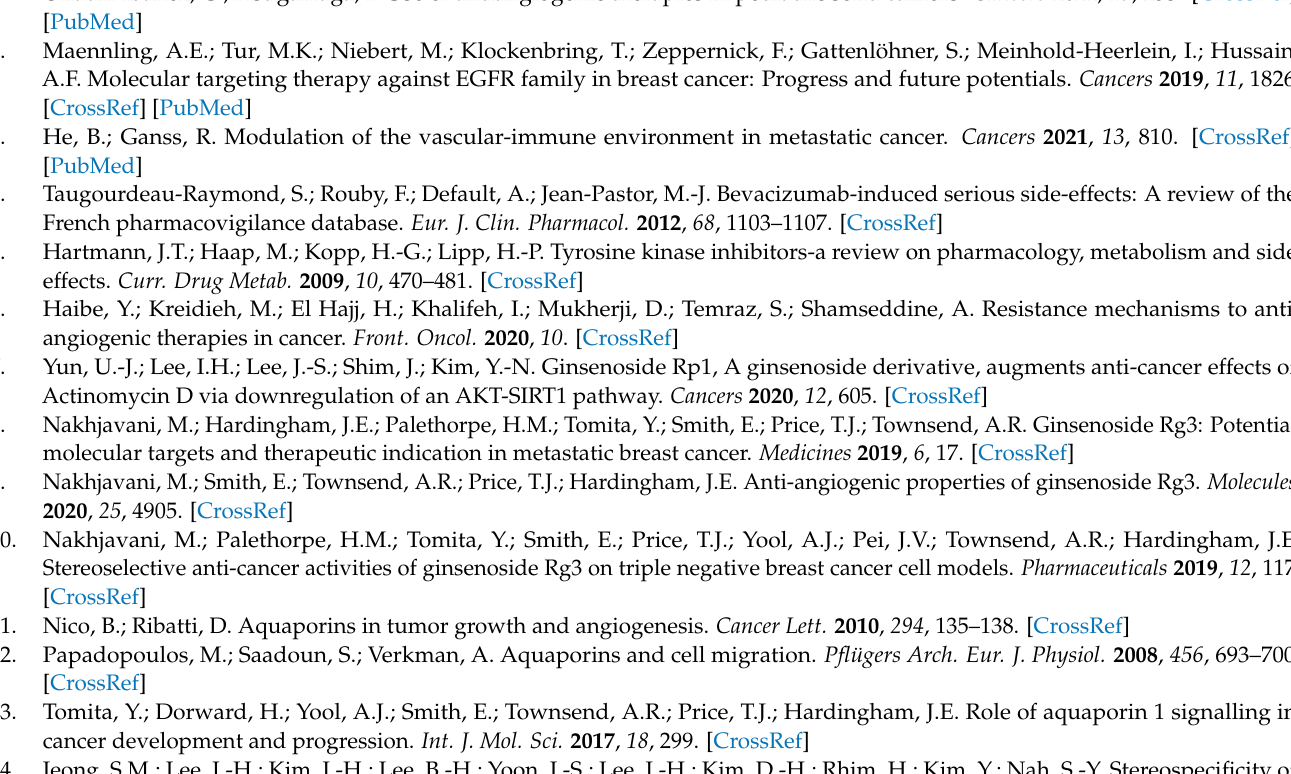
3B-11 cell line following exposure with C3 for 3 days. Figure S2: Western blot analysis of activation of focal adhesion kinase (FAK) in HUVEC exposed to vehicle (V) or C3 (50 µ M SRg3 + 25 µ M RRg3), in normoxia orhypoxiaconditions. FigureS3: HUVECwasexposedtovehicle(V)orC2(25 µ M SRg3 + 12.5 µ M RRg3) for 3 days. Table S1: Design table developed for the RSM